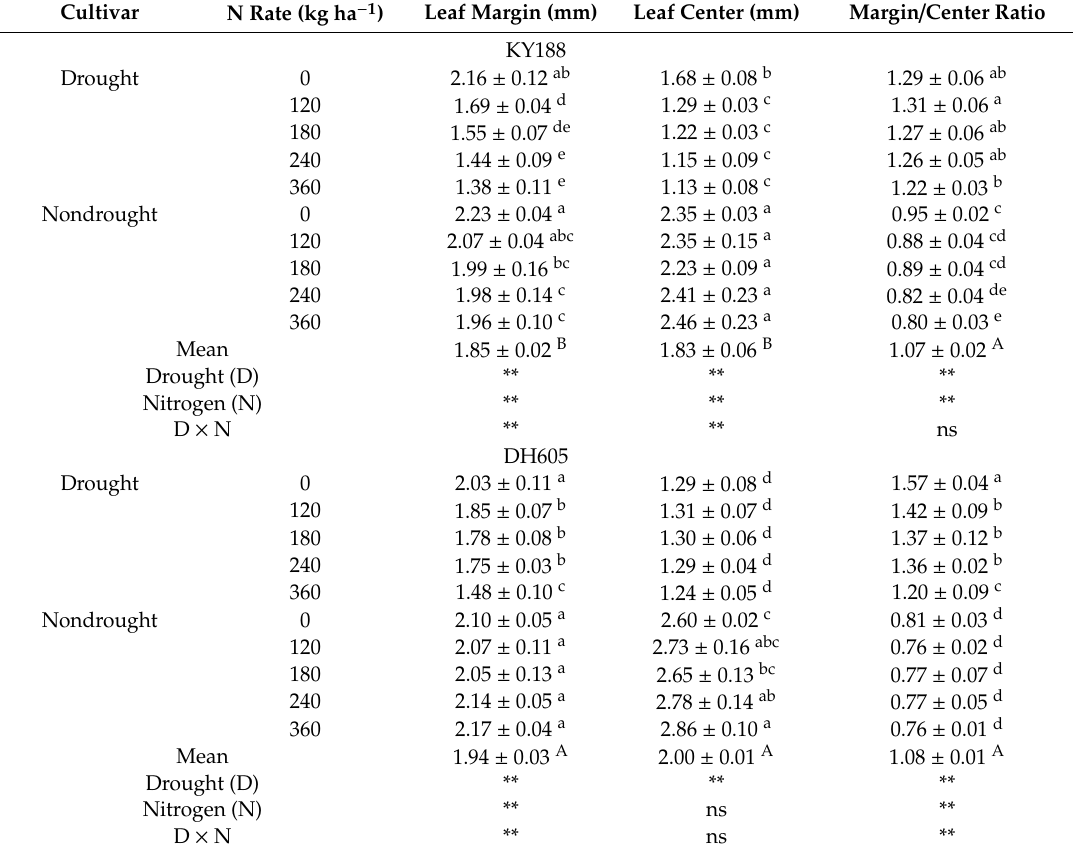
Table 1. Thicknesses of the leaf margin and center of maize grown under di ff erent N levels subjected to drought and nondrought